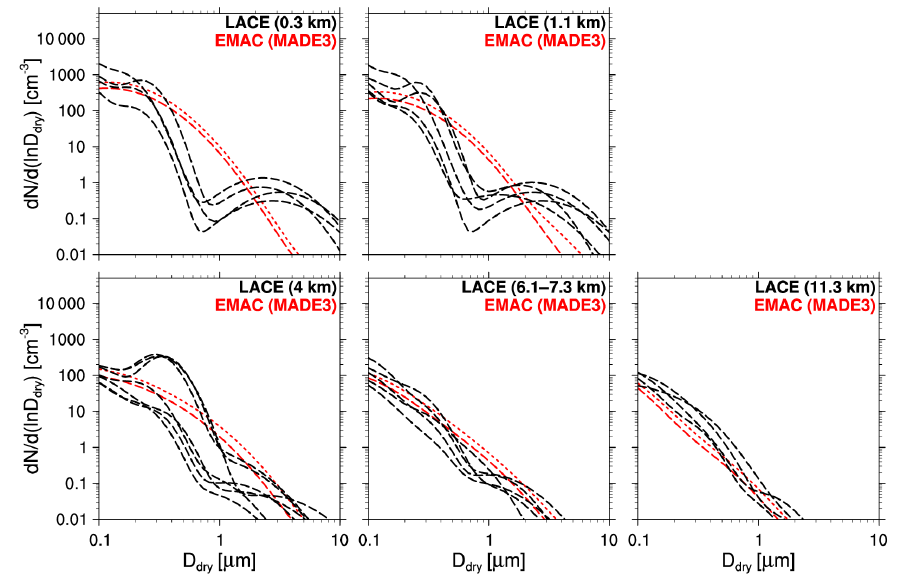
Figure 8. Aerosol particle size distributions in the reference simulation with MADE3 (red) vs. measurements (black) for four to five individ- ual flights (depending on altitude) during the LACE campaign over northeastern Germany. Dashed lines represent mean values; dotted lines represent standard deviations, which are only shown in the direction of larger values for